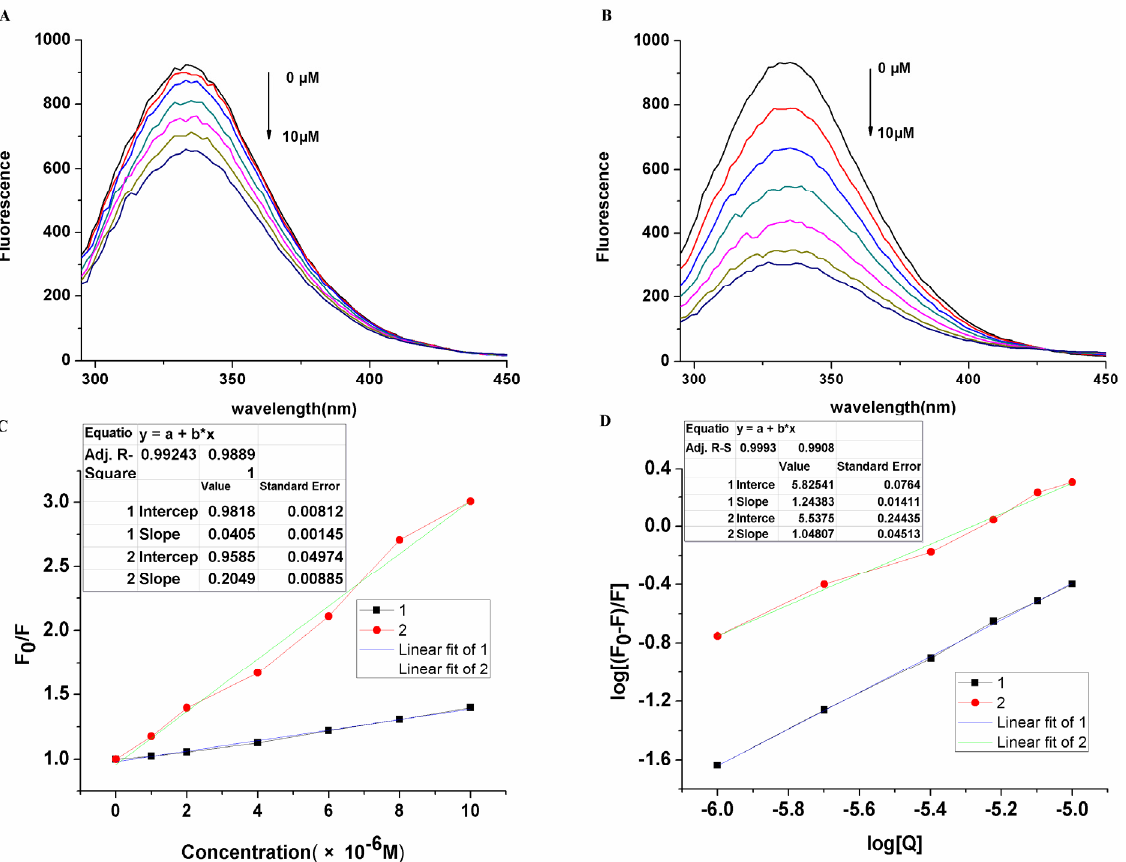
Figure 4. Fluorescence emission spectral changes of BSA (30 µM) on the addition of varying concentrations of saccharide substituted zinc phthalocyanines at the concentration of 0, 1, 2, 4, 6, 8, 10 µM. ( A ) glucose substituted zinc phthalocyanine; ( B ) lactose substituted zinc phthalocyanine; ( C ) linear relationship of fluorescence quenching; ( D ) logarithm relationship of fluorescence